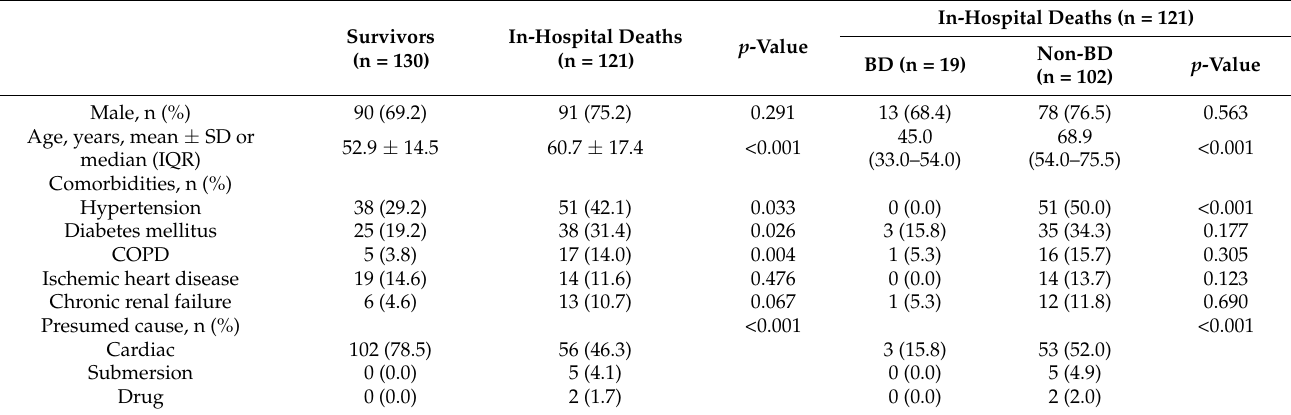
Figure 1. Flow chart for inclusion of patients in the study. OHCA, out-of-hospital cardiac arrest; TTM, targeted temperature management; BD, brain death. Table 1. Characteristics of the included patients.